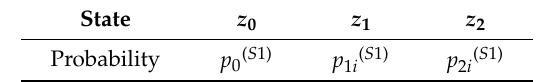
Table 1. Probability determination for particular states of the S1 network configuration.